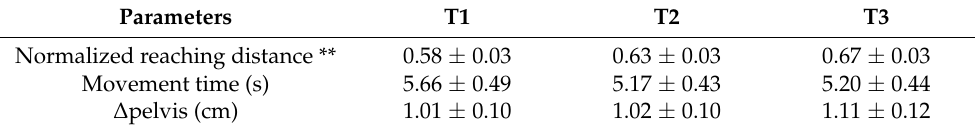
Table 2. Results for the kinematic parameters, mean and standard error of the whole population. Parameters T1 T2 T3 Normalized reaching distance ** 0.58 ± 0.03 Movement time